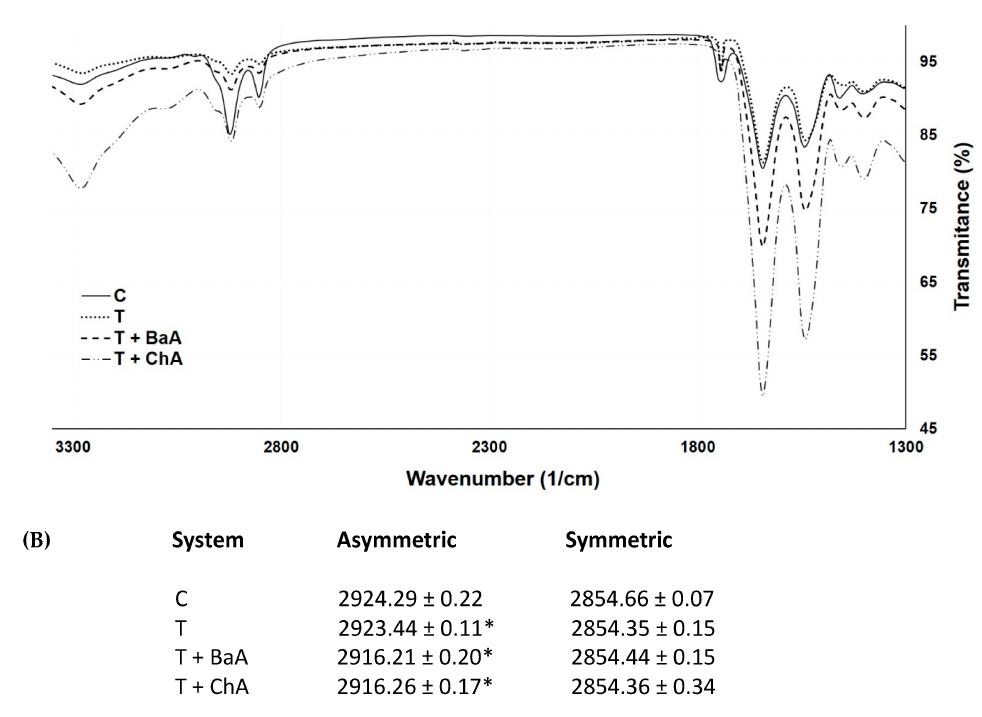
Figure 6. ( A ) Representative ATR-FTIR spectra of porcine ear skin. Untreated (control, C); treated with Transcutol ® (T); treated with batyl alcohol/Transcutol ® (T + BaA); treated with chimyl alcohol/Transcutol ® (T + ChA); ( B ) Frequencies of the CH 2 asymmetric and symmetric stretching vibrations of the stratum corneum lipid acyl chains. Mean ± SD ( n = 6). * p < 0.05.